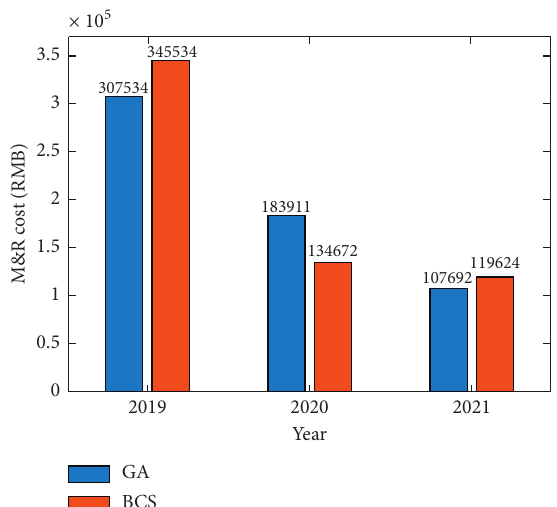
Figure 11: Budget allocation in each year under performance